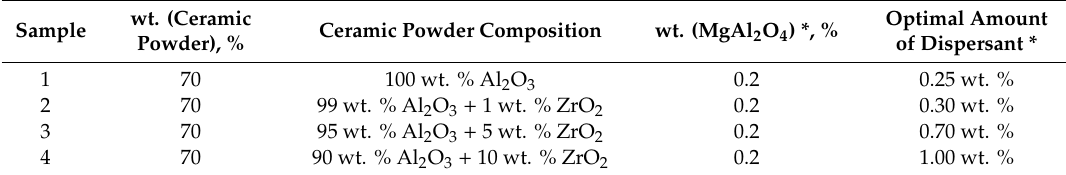
Table 5. The compositions of stable suspensions for preparation of monolithic Al 2 O 3 and Al 2 O 3 –ZrO 2 composite ceramics.